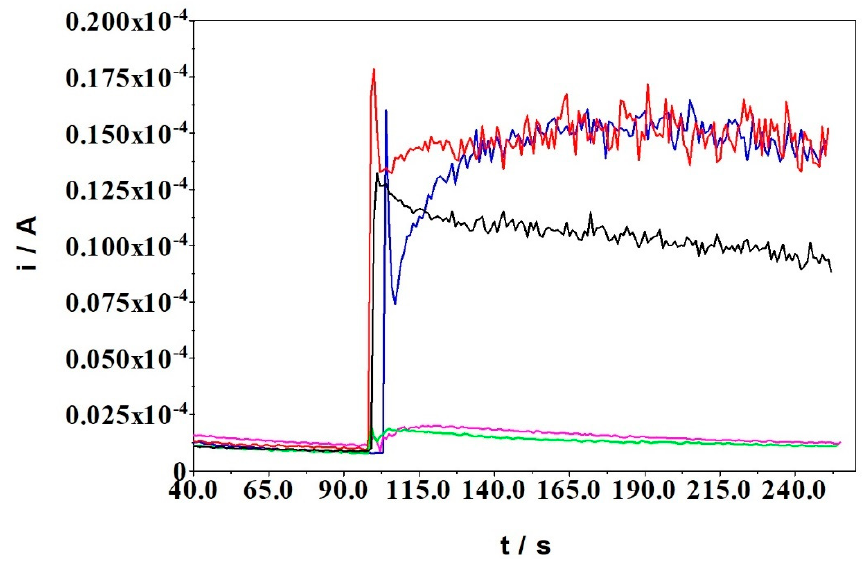
Figure 10. Amperometric response for 0.64 mM cholesterol (black line), 5 mM NaCl/methanol (green line), 105 µ L methanol (pink line), NaCl/methanol + cholesterol (red line), and methanol + cholesterol (blue line) added in the background mixture (chloroform-TBAP + acetic anhydride + H 2 SO 4 ).